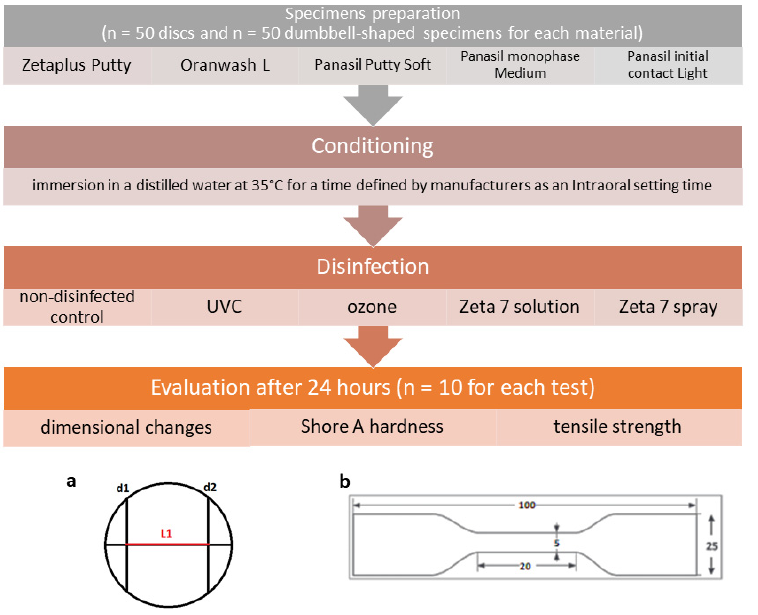
Figure 7. Study design with a schematic representation of ( a ) the test block used for the measure- ment of dimensional change in accordance with the ISO 4823:2015 standard and ( b ) the dumbbell- shaped test specimen used for the measurement of tensile strength in accordance with the ISO 37:2017(E) standard.